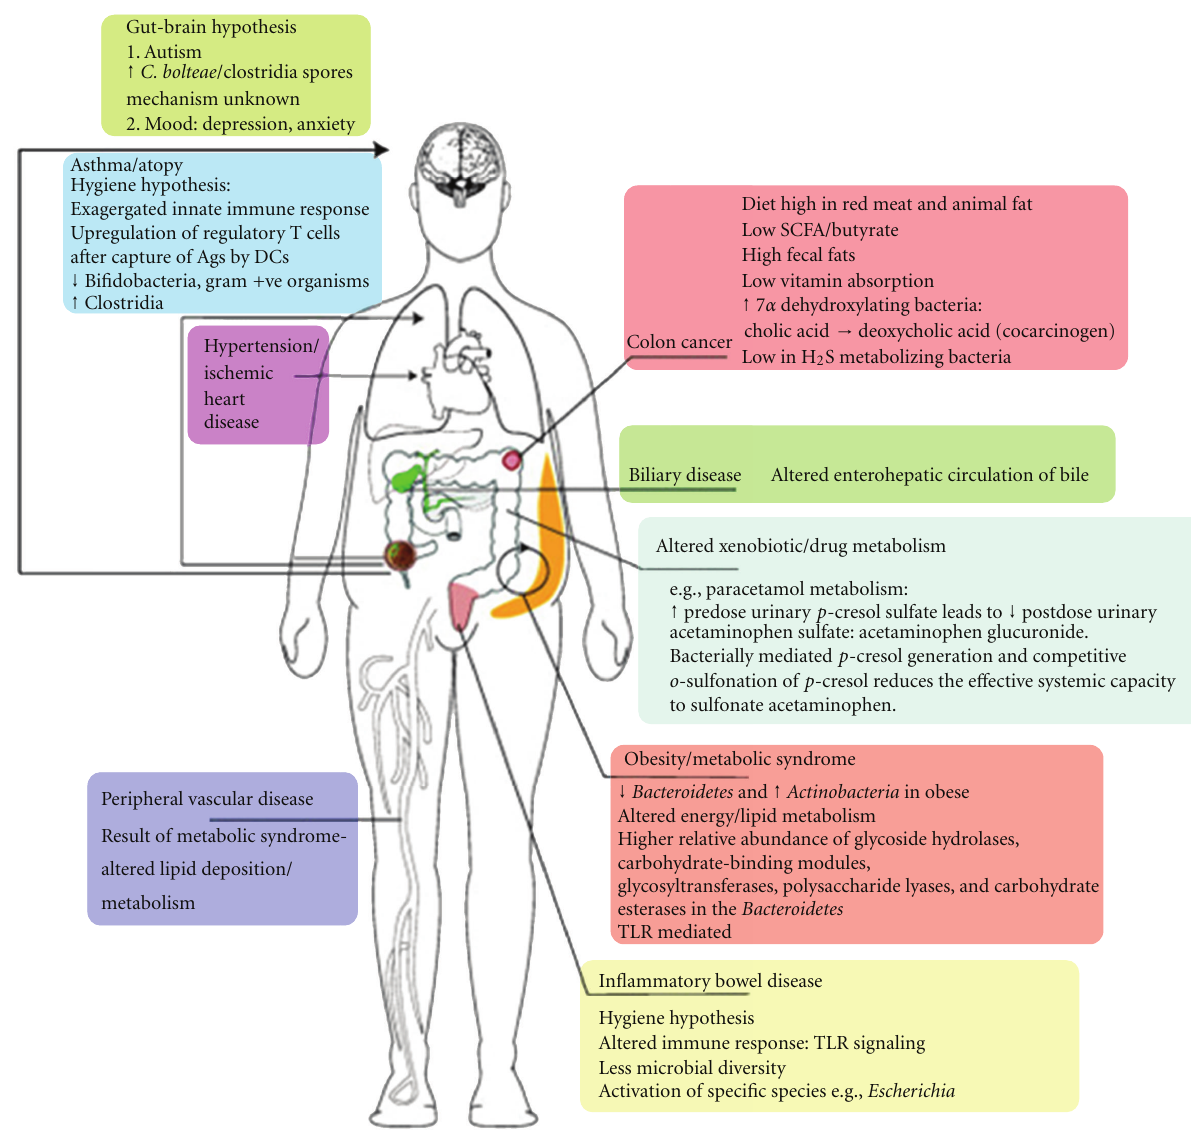
Figure 3: Diseases influenced by gut microbial metabolism. The variety of systemic diseases that are directly influenced by gut microbial metabolism and its influence on other mammalian pathways, such as the innate immune system, are shown. Specifically highlighted are the metabolic pathways involved in drug metabolism and obesity that are directly influenced by the gut microbial content. Ags, antigens; C. bolteae , Clostridium bolteae ; DCs; dendritic cells; SCFA, short-chain fatty acid; TLR, toll-like receptor. Kinross et al. Genome Medicine 2011